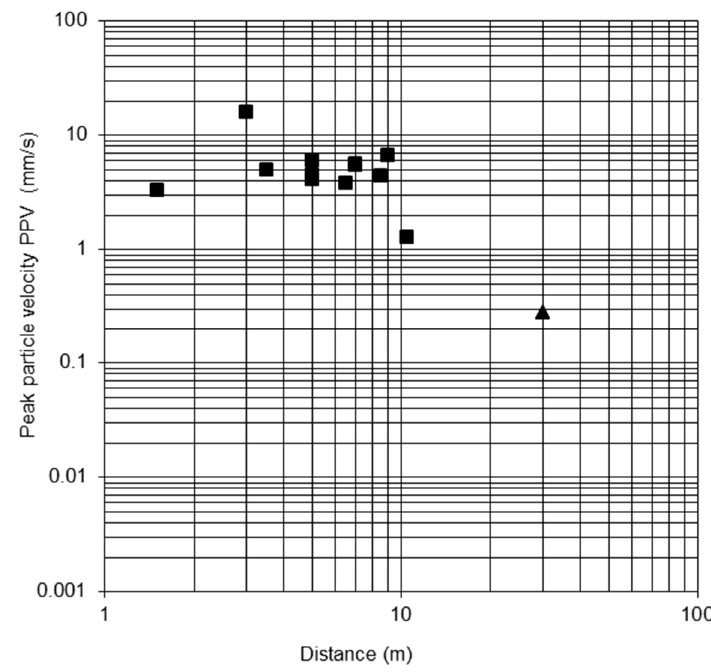
Figure 7. Logarithmic graph of the vibrating roller.